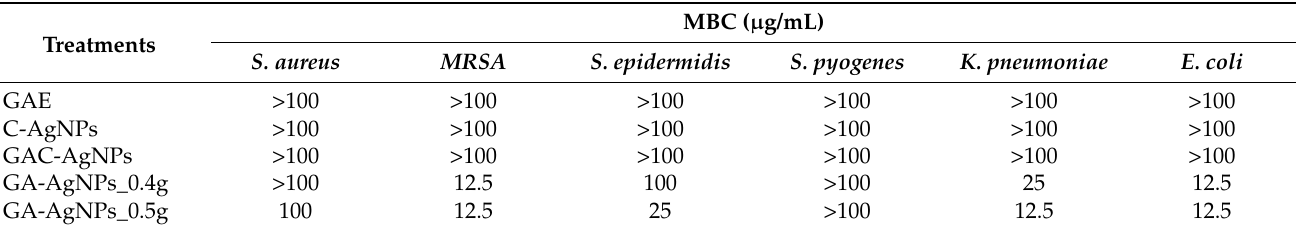
Table 5. MBC of the AgNPs on test